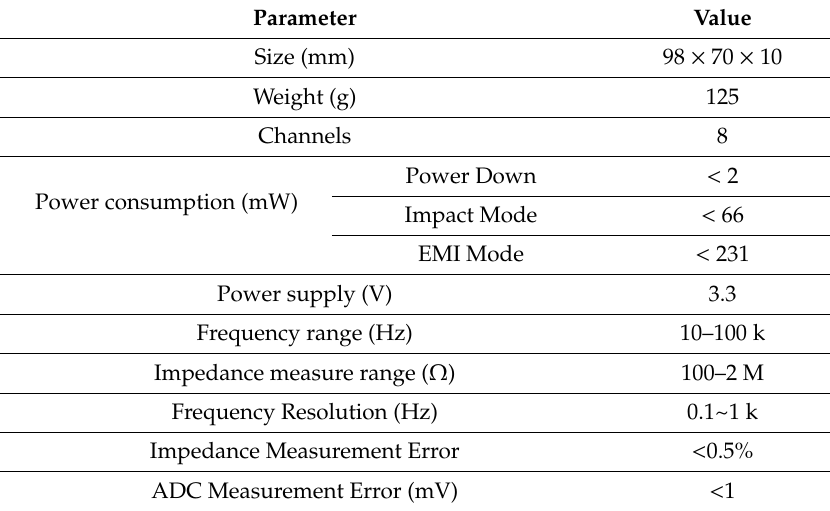
Table 2. Parameters of the SHM system